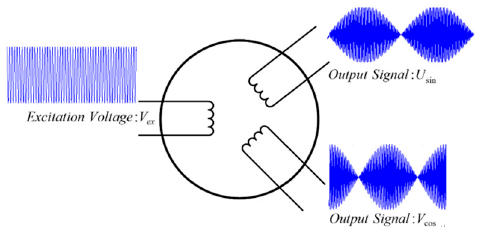
Figure 1. Classic input and output model of an APS.